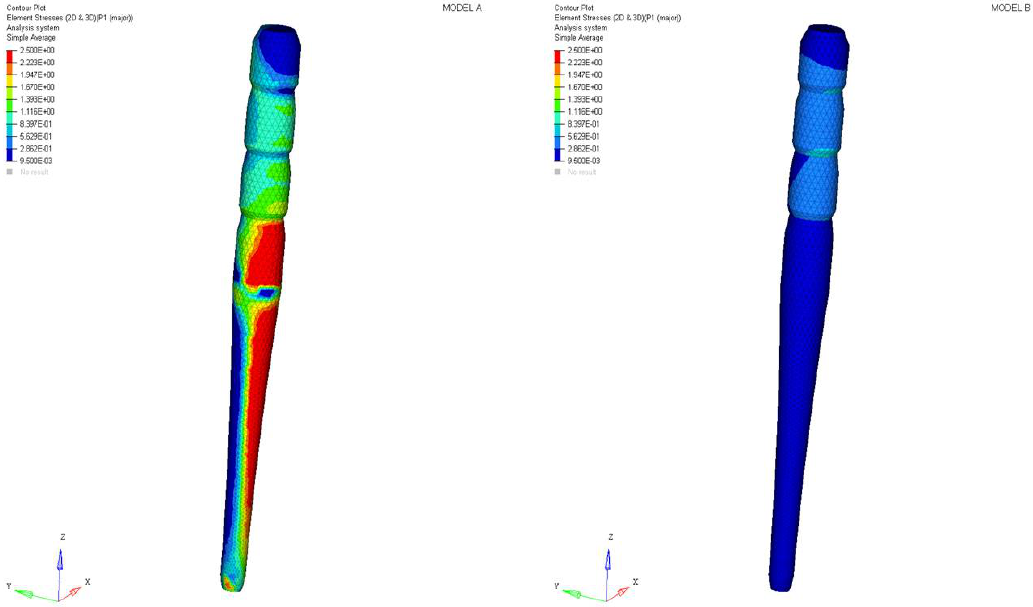
Figure 8. Maximum principal stress distribution (MPa) at the interface between the post and surrounding structures.